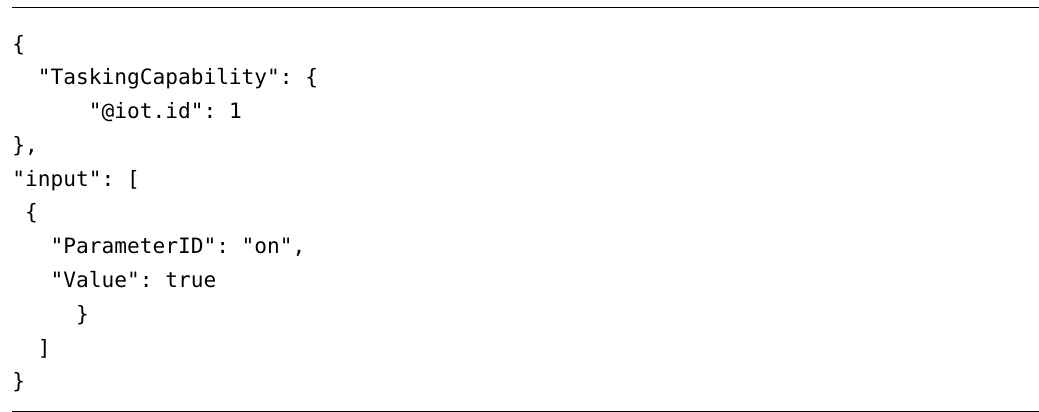
Algorithm 2. A Task from a user to the